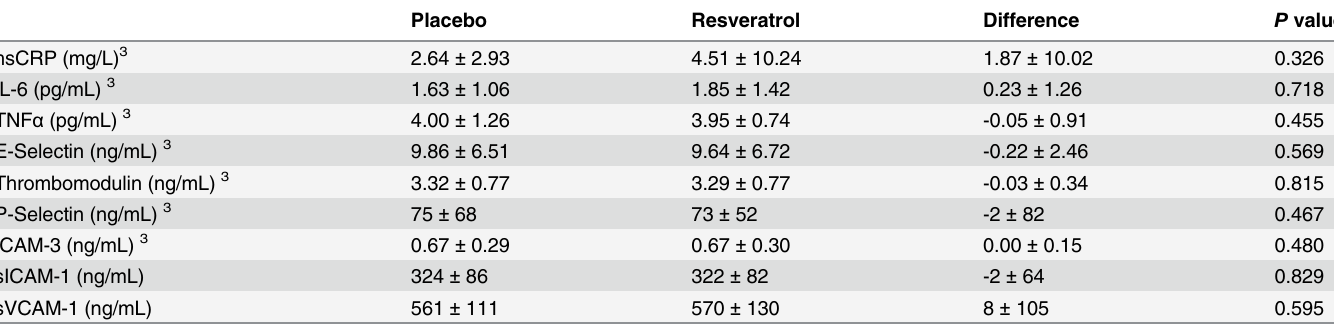
Table 4. Effect of 4-wk resveratrol intake on markers for in fl ammation and endothelial function.